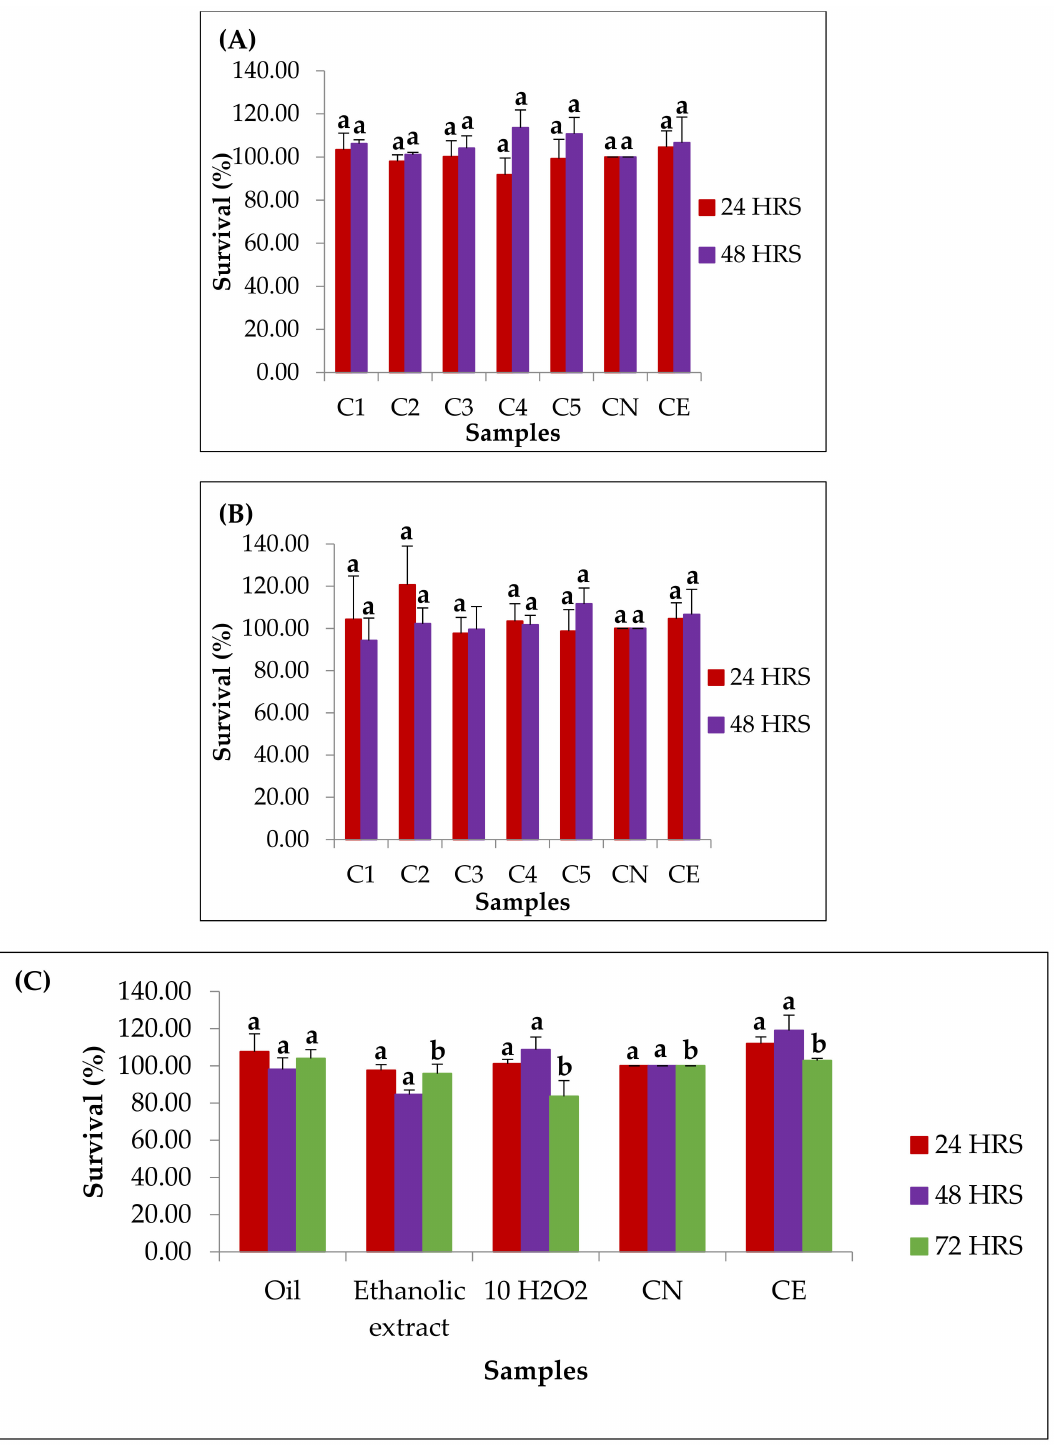
Figure 3. Cytotoxicity data of oil ( A ) and ethanolic extract ( B ) of murici pulp ( B. crassifolia ) obtained by CO 2 -SFE and CO 2 +EtOH-SFE, together with cytoprotection data using 0.05 kg/m 3 of samples in HepG2 cells treated with H 2 O 2 ( C ). * Different letters for the same incubation time showed a difference in significance level of 5% ( p < 0.05) (ANOVA; Tukey test for multiple comparisons); C1: concentration 0.20 kg/m 3 ; C2: concentration 0.10 kg/m 3 ; C3: concentration 0.05 kg/m 3 ; C4: concentration 0.025 kg/m 3 ; C5: concentration 0.01 kg/m 3 ; CN: negative control; CE: ethanol control; 10 H 2 O 2 : peroxide